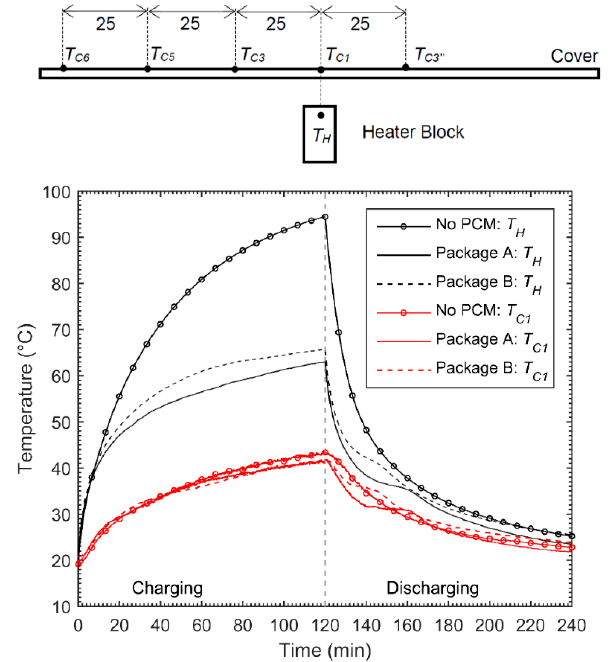
Figure 9. Temperature profile of the heater (TH) and the cover surface (TC1) for the experiment with no PCM package, package A, and package B with the thermal spreader and a constant power input of 5 W for 120 min.